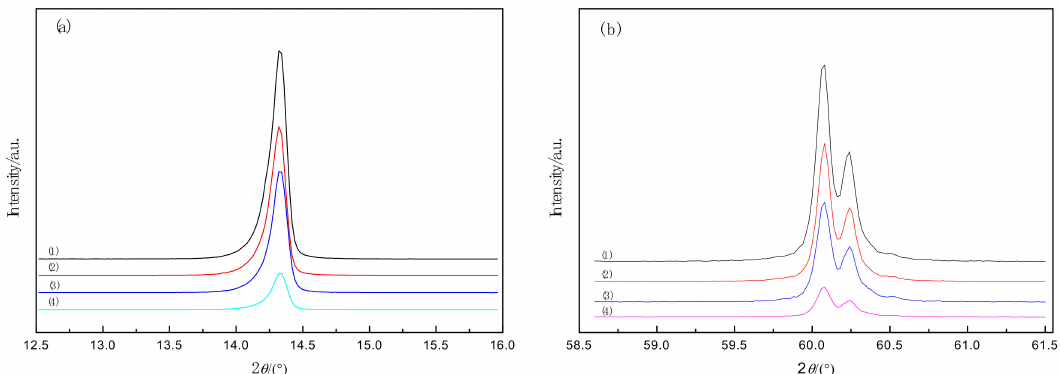
Figure 4. Peaks of XRD patterns for different molybdenite samples ( a ) (002) peak and ( b ) (008) peak. (1) P-0; (2) P-450; (3) P-550; (4)